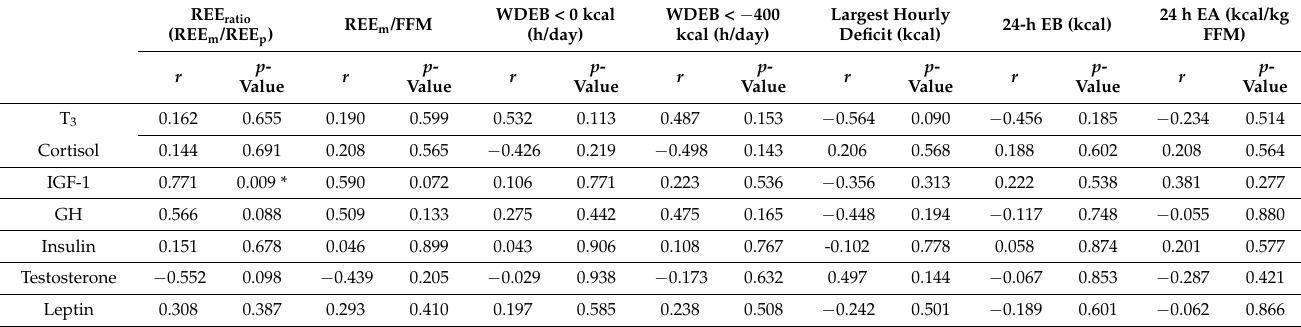
Table 5. Associations of REE ratio and WDEB variables with metabolic markers in the participants.